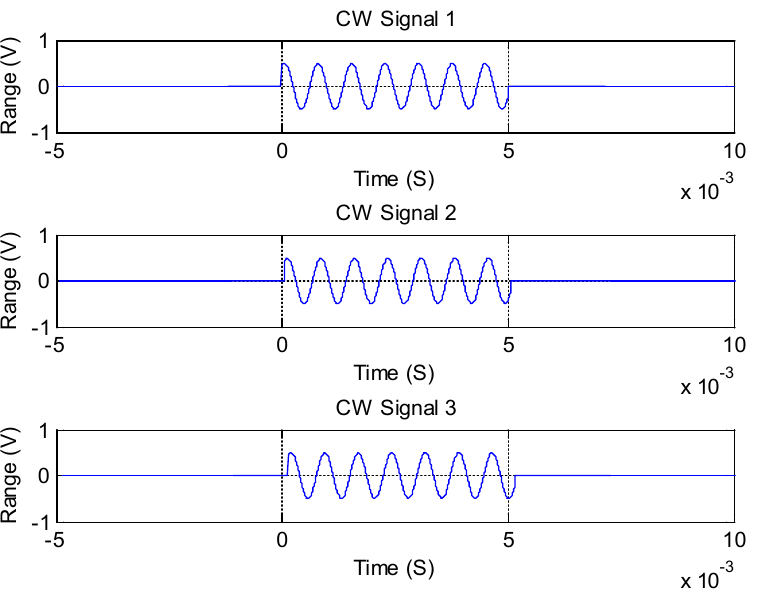
Figure 5. The original three-channel original input signal waveform diagram.